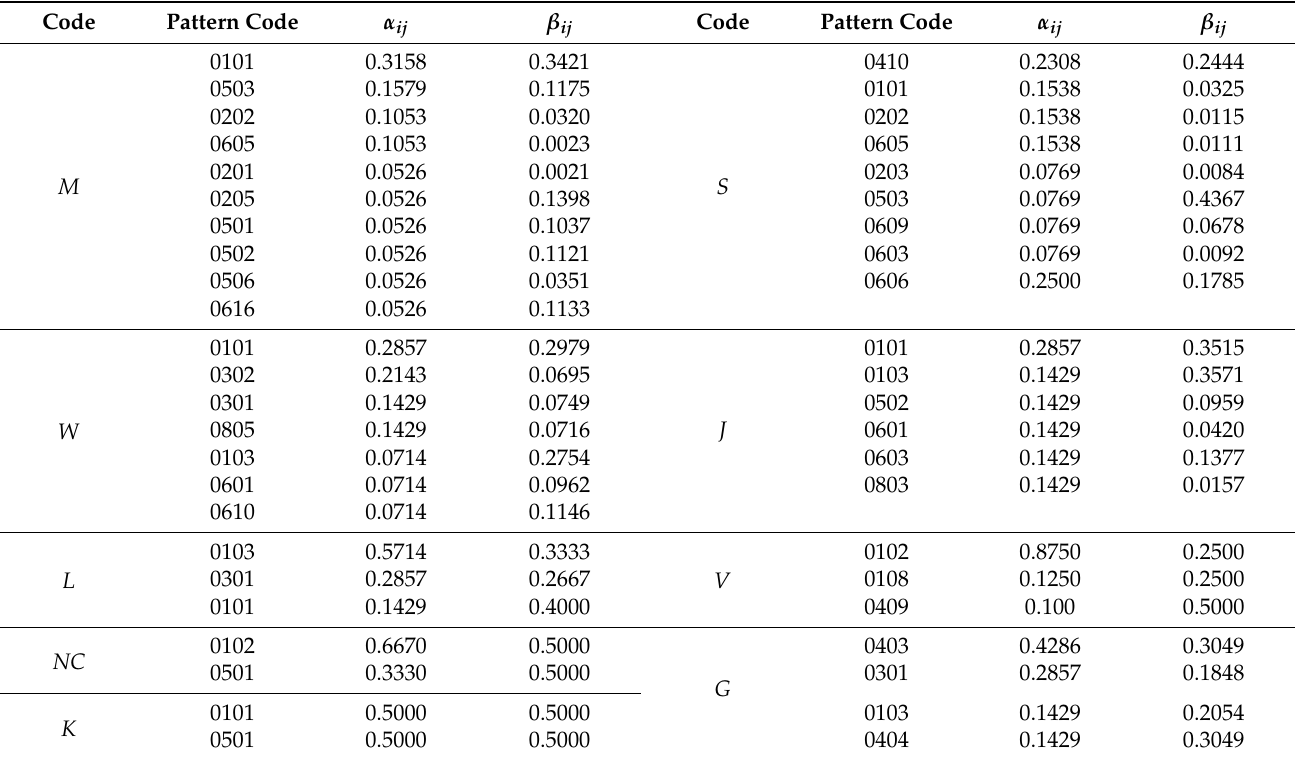
Table 7. Frequency ratio of failure modes and influence degree of failure modes of each component of machining center.